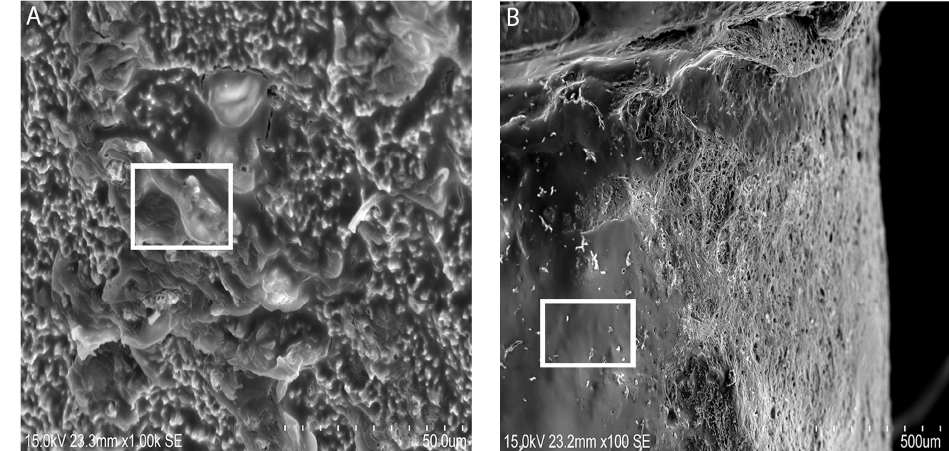
Figure 3. Representative SEM images from the surface of ( A ) ST group with random distribution of parts like bone formation at a higher magnification; Representative SEM images from the surface of ( B ) TiUn group with bone-like formations identified on their surface, confirmed with Raman analysis. (Boxed areas showing deposits later confirmed for apatite structure using Raman spectroscopy.) Table 1. Observed defects on the implant